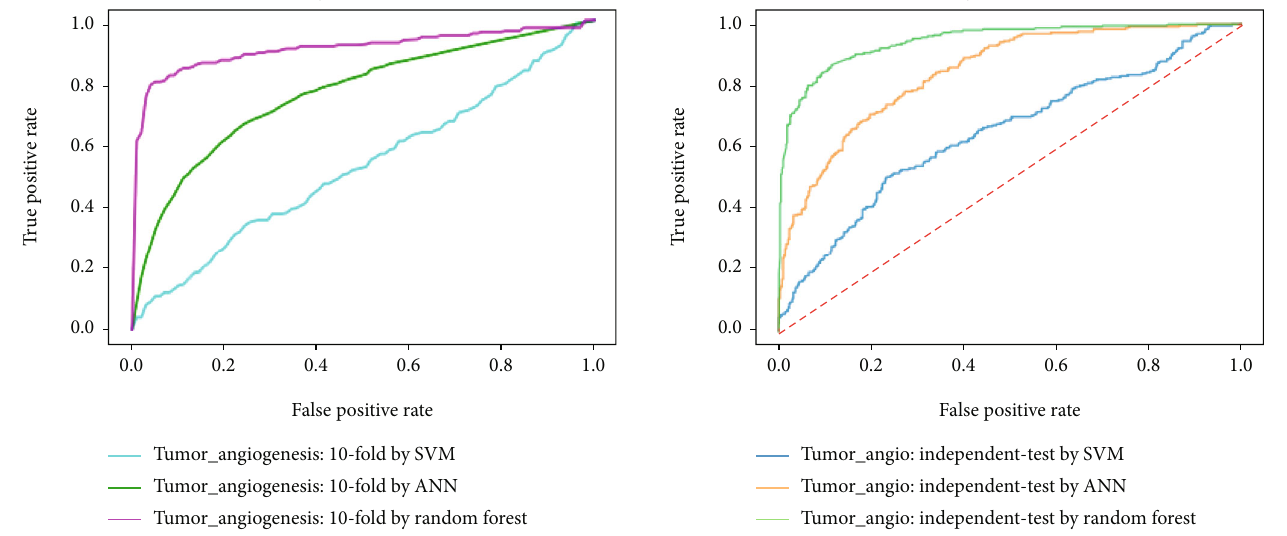
Figure 13: Comparison based on 10-folds.